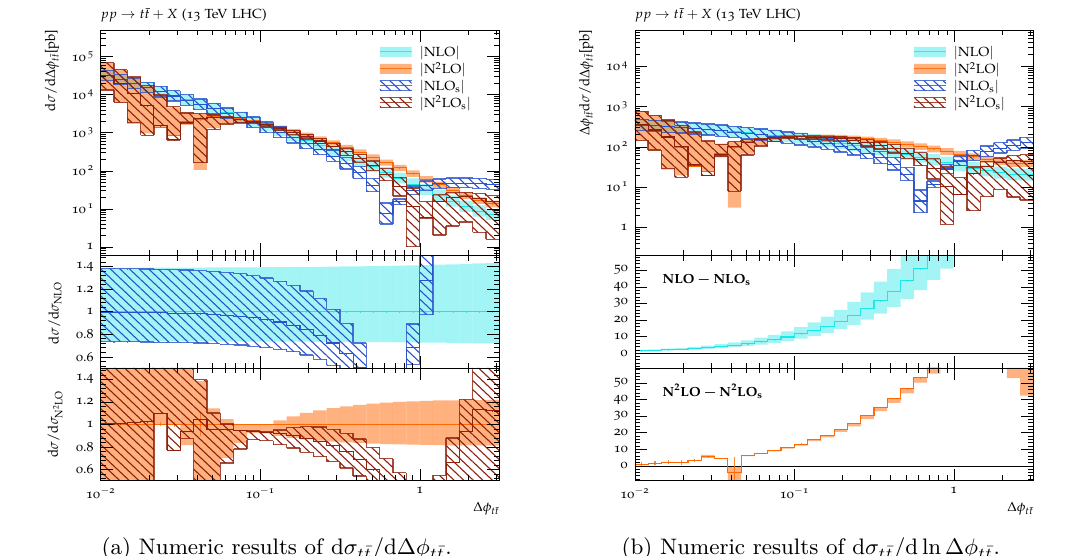
and the weighted ∆ φ spectra of the process t ¯ t t ¯ t